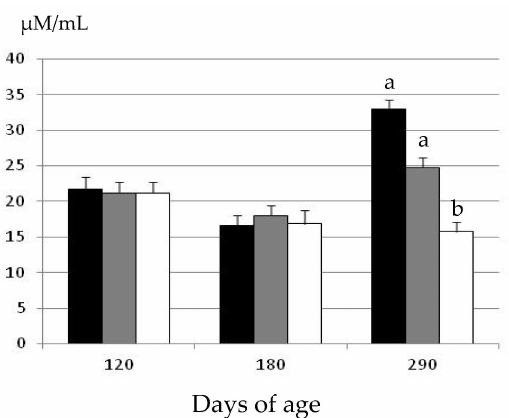
Figure 2. Changes over time in the mean values ( ± S.E.M.) for plasma hydrogen peroxide concentrations ingiltsconfinedandfedadlibitumwithobesogenicdiets(groupOB,blackbar)andgiltswithopportunity of exercise and controlled non-obesogenic diets without or with metformin (groups EXE and MET, grey and white bars, respectively). Significant di ff erences are denoted by di ff erent superscript letters among treatments (a (cid:44) b: p <